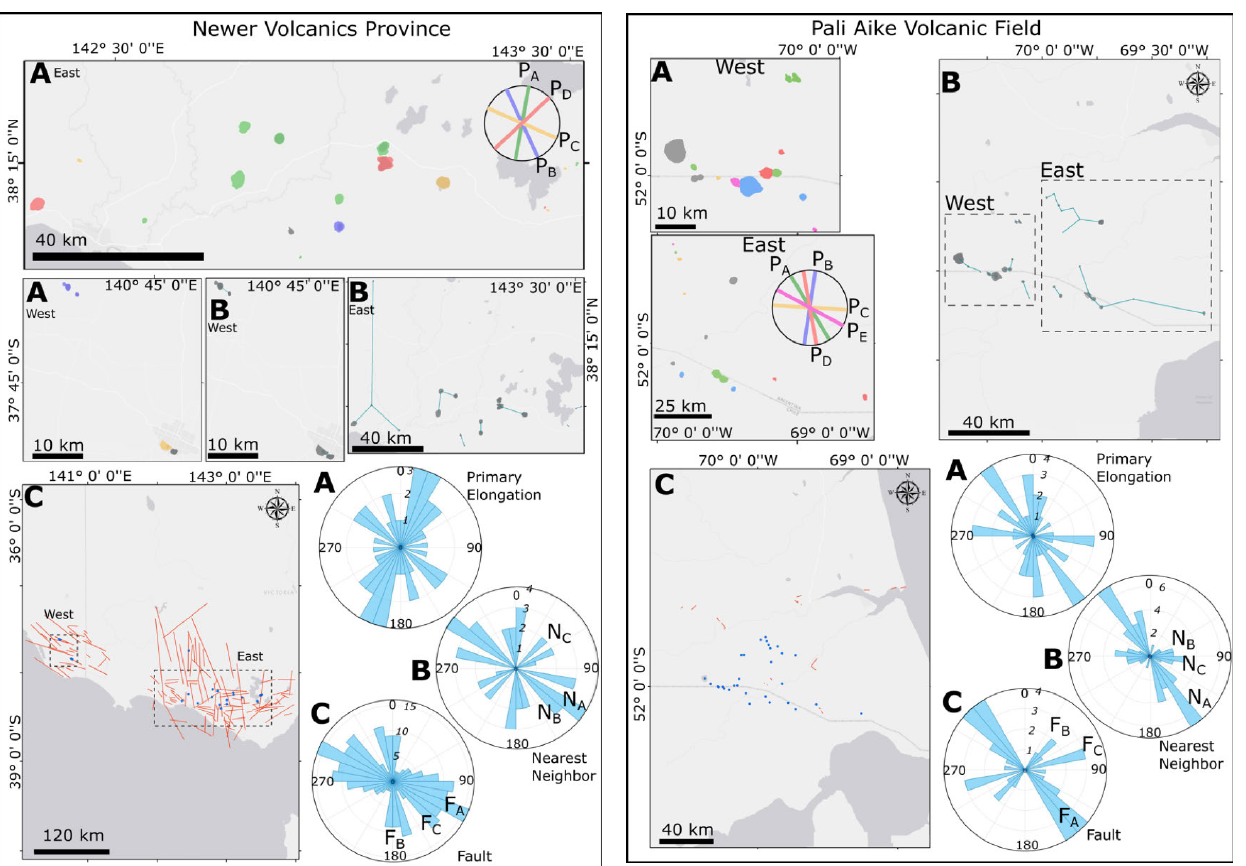
Figure 7: Pali Aike Volcanic field spatial (map) and ori- entation data (rose diagram).. [A] Maars measured for primary elongation orientation. Colors represent mode Green (PA), Blue (PB), Orange (PC), Red (PD), Pink (PE), Grey (none). [B] Nearest neighbor lines between all maars. Inset for A shown. [C] Maars (blue dots) and fault lines (red lines) from a regional